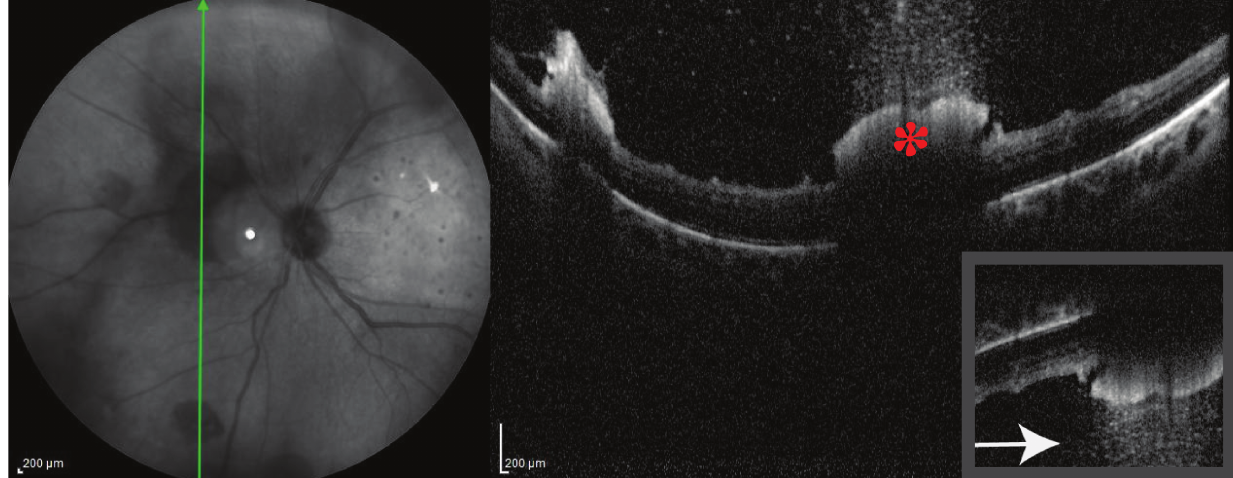
Figure 2. Optical coherence tomography (OCT) of one of the lesions in the left eye shows hyperreflectivity of the inner retina (asterisk) with posterior shadowing (“rain-cloud” sign) alongside vitreous aggregates extending to the vitreous cavity. In the inset, by inverting the image, the resemblance to a “snowing-cloud” becomes more evident with vitreous aggregates representing snowflakes